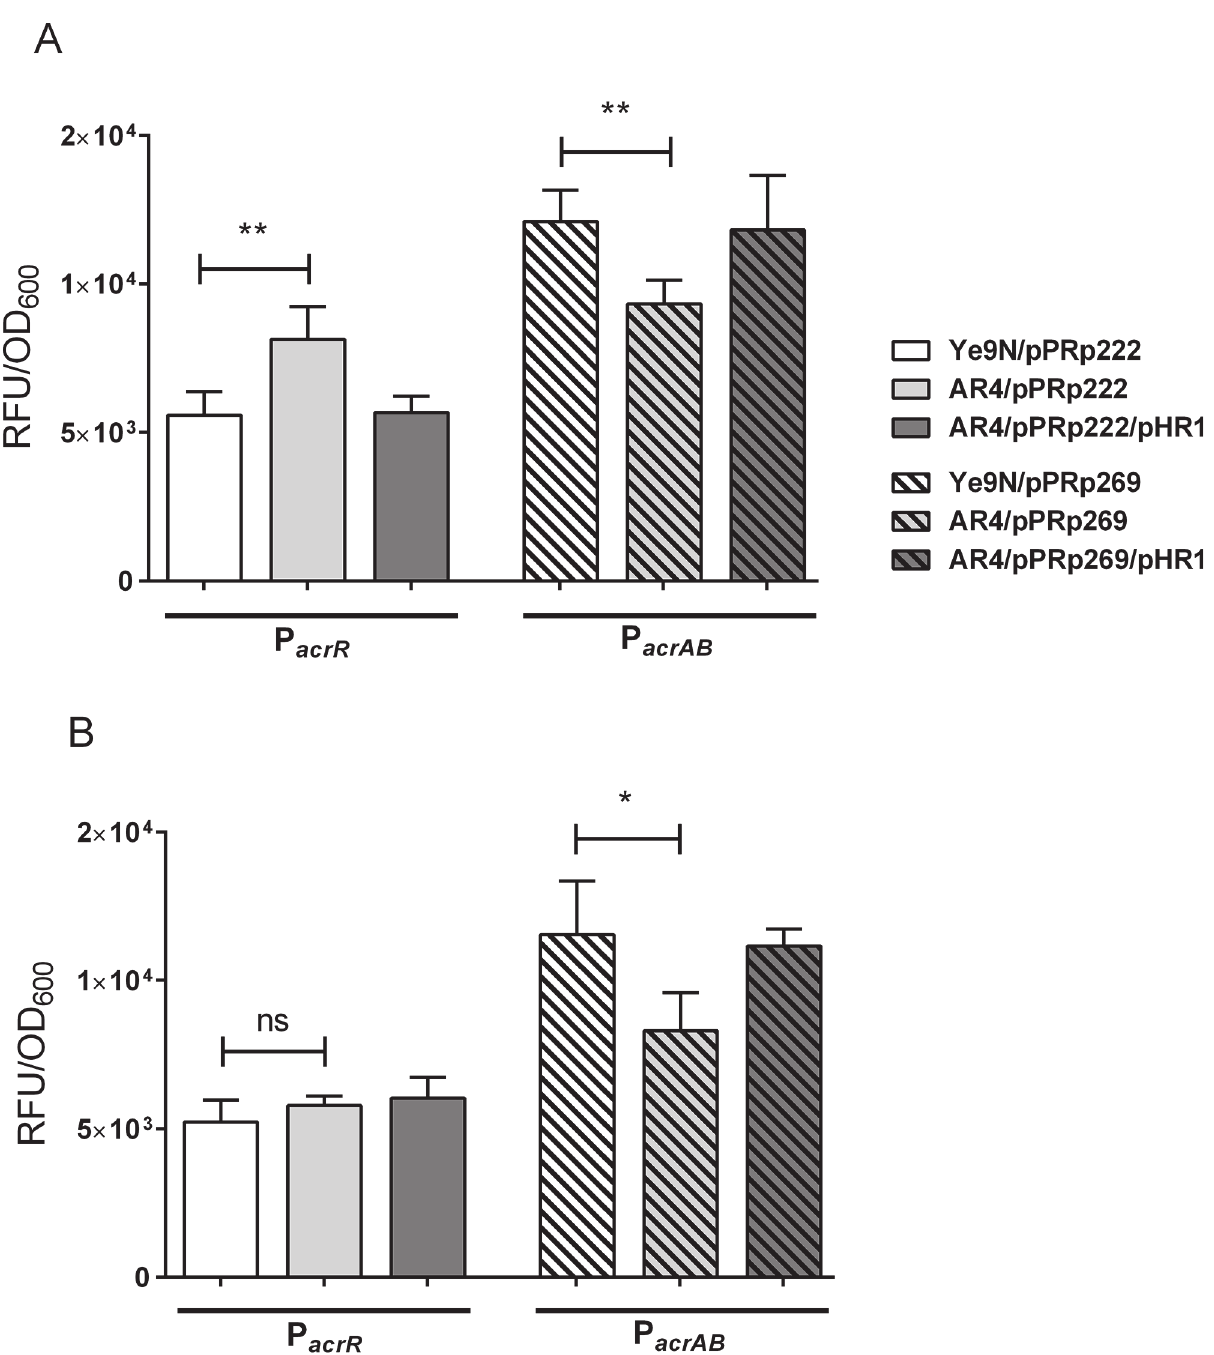
Fig 5. Effect of OmpR and growth phase on acrR and acrAB promoter activity. Strains Ye9 and AR4 carrying the promoter- gfp fusion constructs were cultivated in LB medium at 27°C to exponential phase (A) and stationary phase (B). Data represent mean fluorescence activity values normalized to the OD 600 of the culture ( ± standard deviation) from three independent experiments performed in triplicate. The significance of differences between the values was calculated using Student ’ s unpaired t -test (ns [non significant] — p > 0.05, * — p < 0.05, ** — p < 0.01).